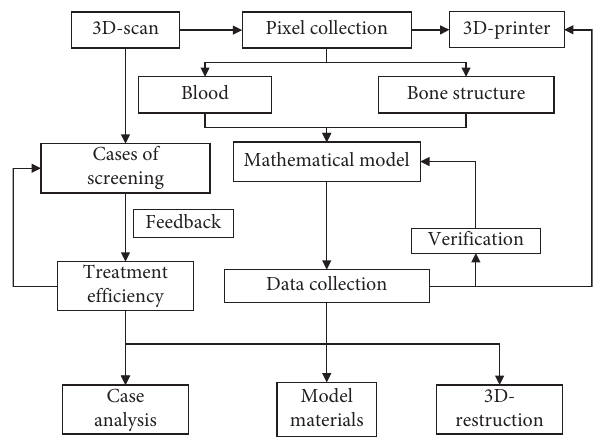
Figure 4: The schematic diagram for the process of 3D- recon- struction for bone